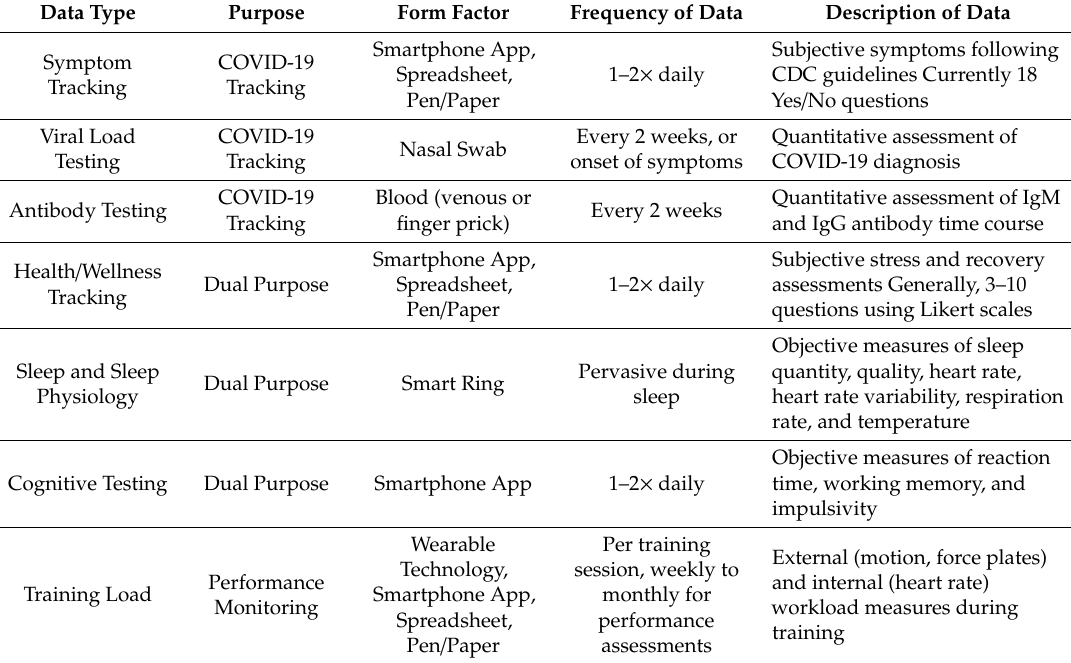
Table 1. Data Types and